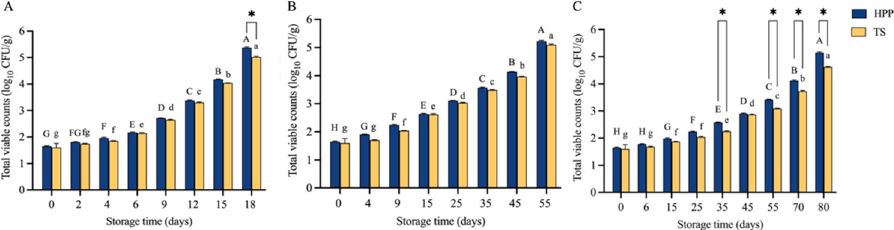
Figure 3. Changes in total viable counts of HPP and TS marinated lotus root slices during storage: ( A ) storage at 45 °C, ( B ) storage at 25 °C, ( C ) storage at 4 °C. Different letters indicate significant differences during storage ( p < 0.05) for the HPP (uppercase letters) and TS (lowercase letters) marinated lotus root slices. * p < 0.05. HPP, high-pressure processing; TS, thermal-and-soaking.